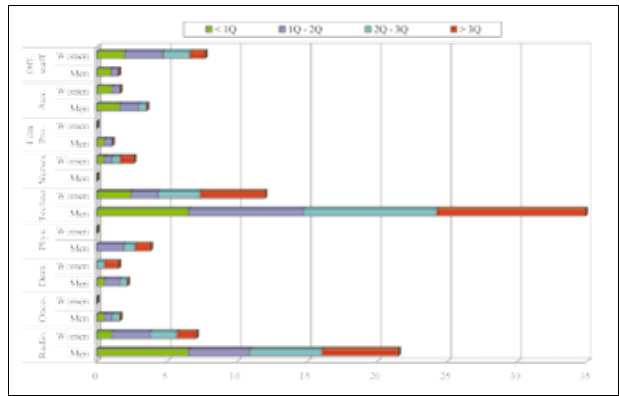
Fig. 3. Distribution of annual dose among medical radiation workers by dose